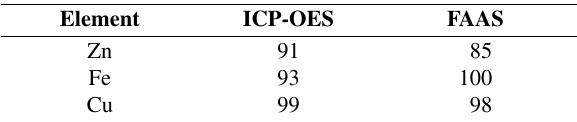
Table 3. Recovery (%) of NIST 1849 by ICP-OES and FAAS